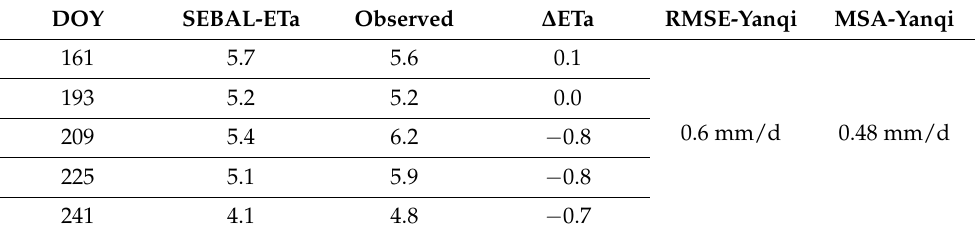
Table 5. Comparison of high-resolution SEBAL derived daily ETa (mm d − 1 ) and observed ETa estimates at Yanqi